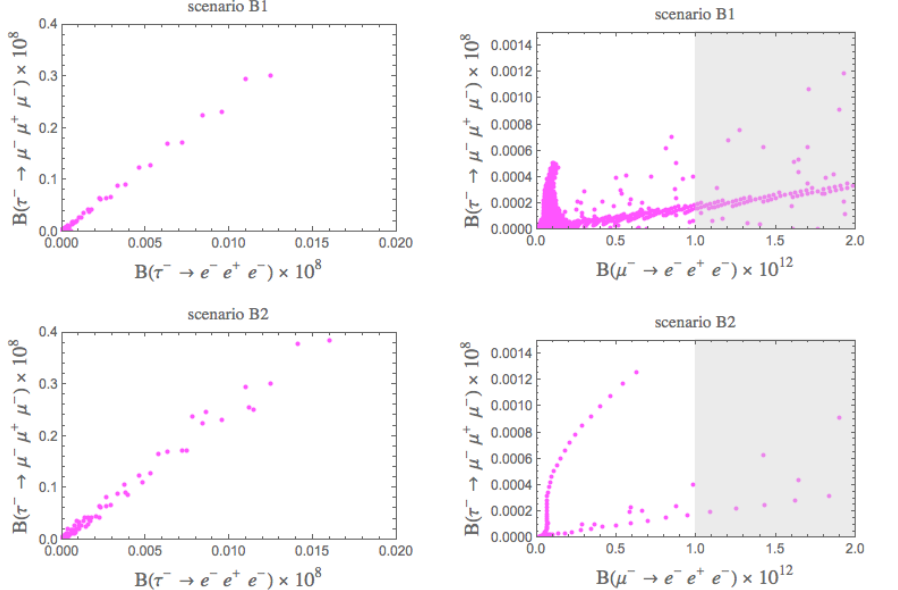
Figure 10 . Scenarios B1 (upper plots) and B2 (lower plots). Correlation between B ( (cid:28) (cid:0) ! (cid:22) (cid:0) (cid:22) + (cid:22) (cid:0) ) and B ( (cid:28) (cid:0) ! e (cid:0) e + e (cid:0) ) (left panel) and between B ( (cid:28) (cid:0) ! (cid:22) (cid:0) (cid:22) + (cid:22) (cid:0) ) and B ( (cid:22) (cid:0) ! e (cid:0) e + e (cid:0) ) (right panel). The gray shaded region in the right panel is excluded by the experimental bound B ( (cid:22) (cid:0) ! e (cid:0) e + e (cid:0) ) < 1 (cid:1) 10 (cid:0) 12 .